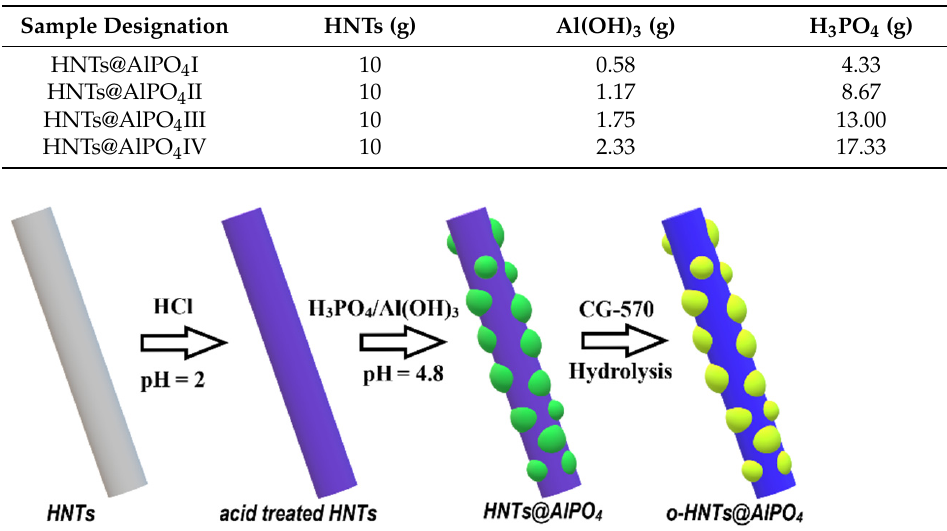
Table 1. The details of the sample designations for the HNTs@AlPO 4 nanocomposites.